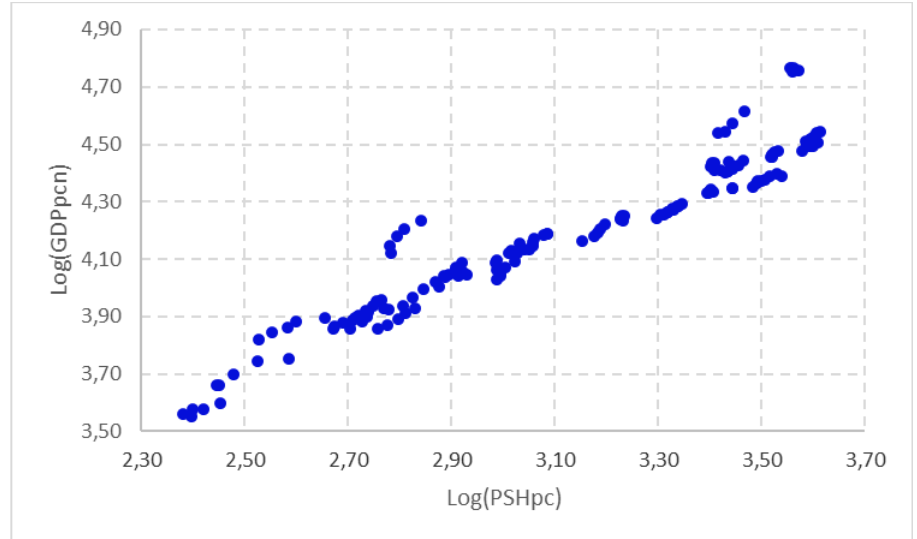
Figure 5. Relationship between PSH and the level of economic development adjusted with the Gini Index of EU-28